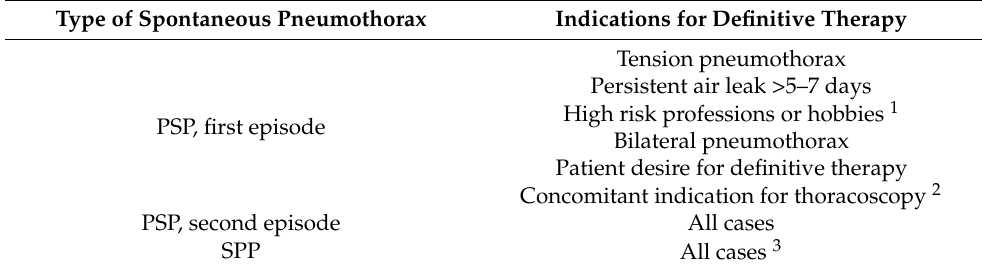
Table 2. Indications for definitive management and prevention of recurrences in spontaneous